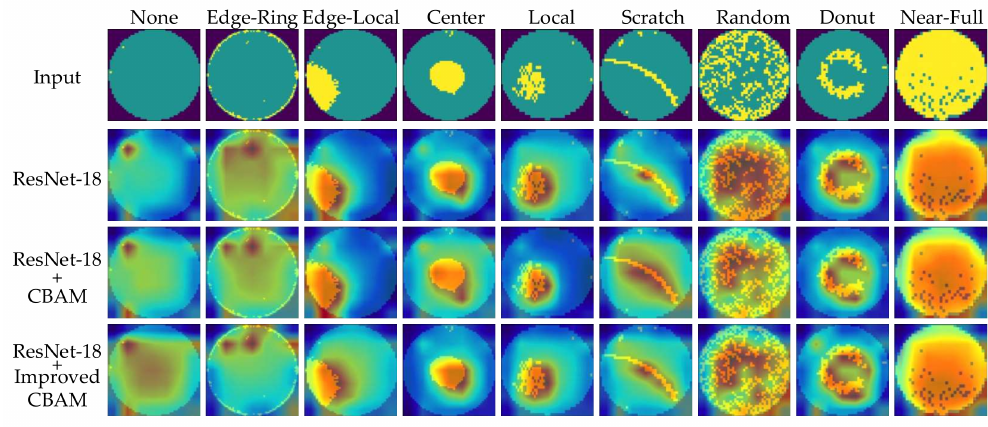
Figure 13. Visualization based on